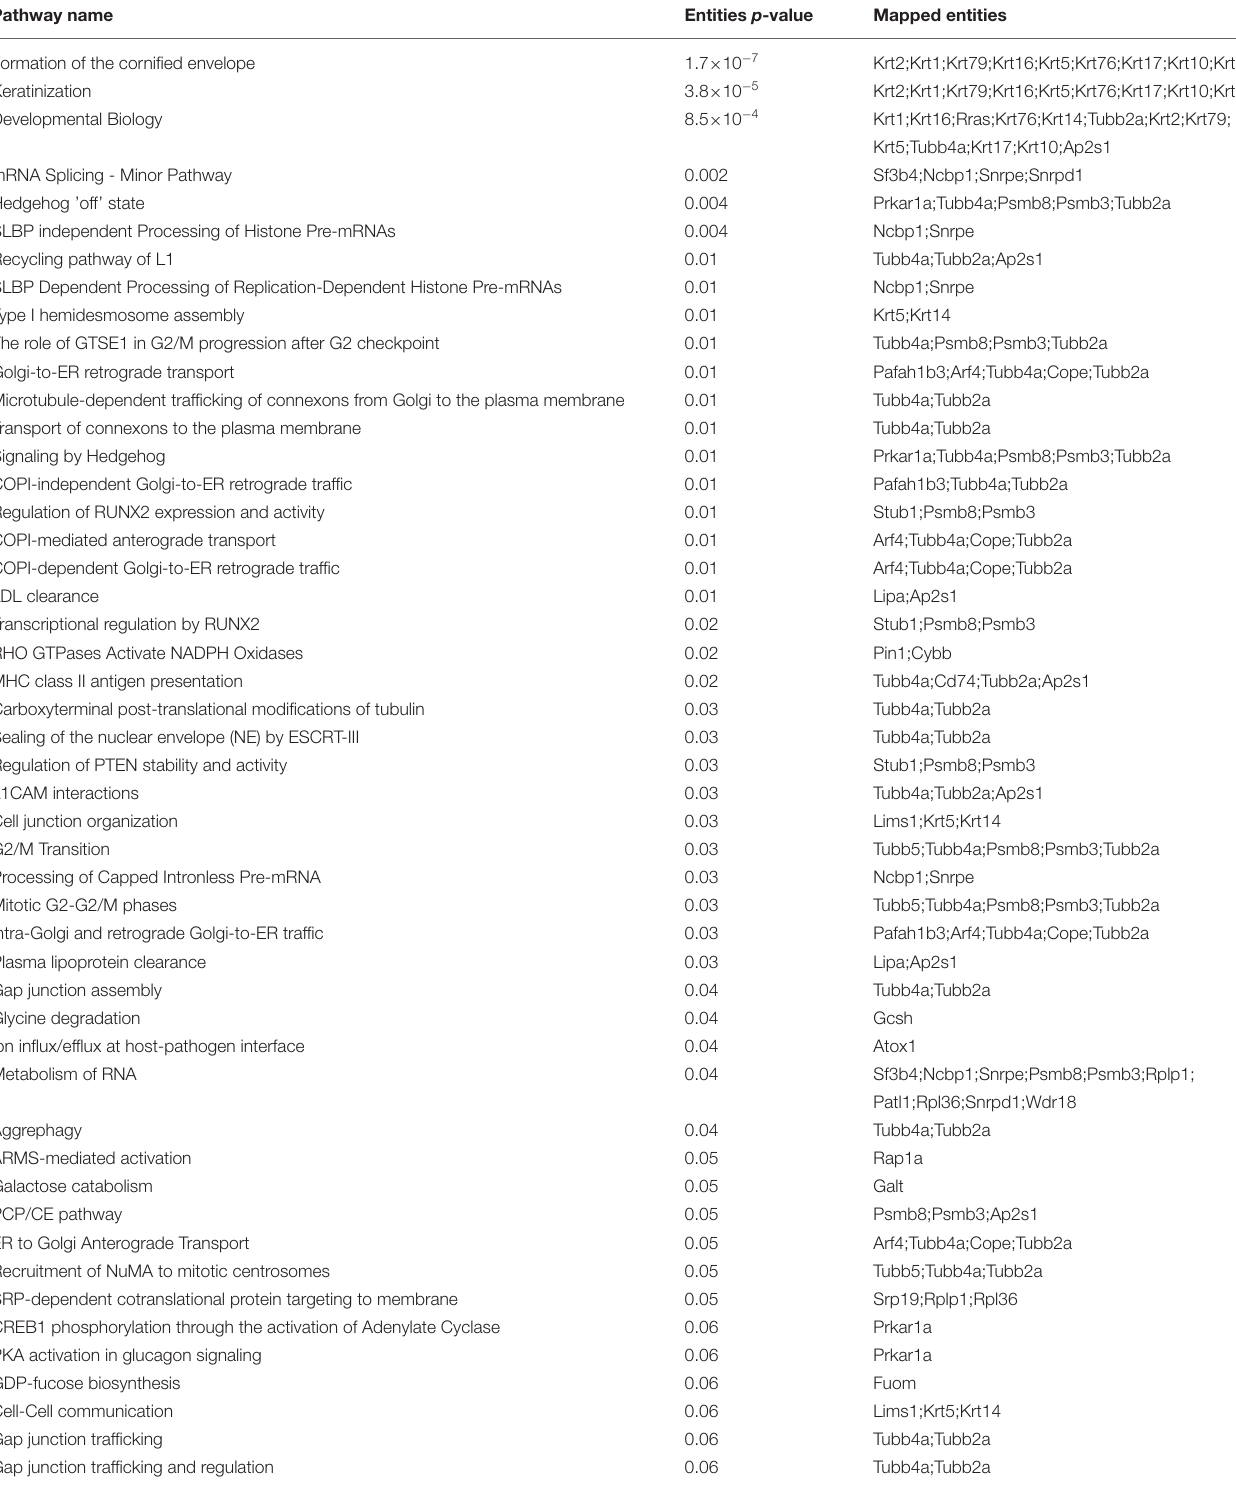
TABLE 3 | Top pathways associated with upregulated proteins altered (at 2-fold change) with